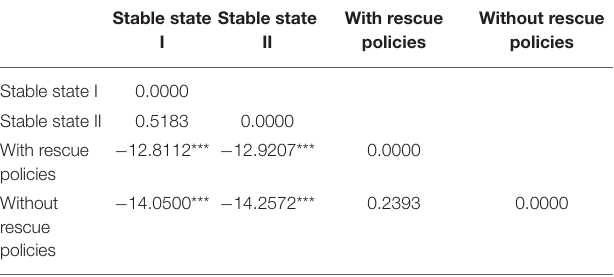
TABLE 8 | Results of t -test for testing the significance of the difference between the entropies of the stock network for different sub-periods in the Shanghai stock